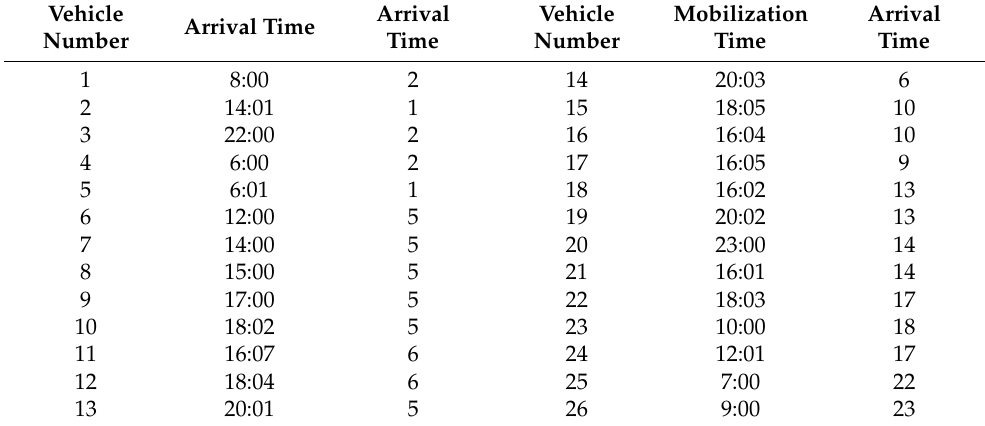
Table 7. Adjusted experience